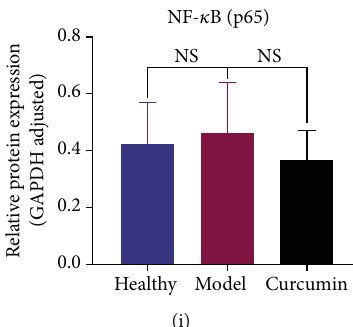
Figure 8: Curcumin treatment reduces ubiquitination and NF- κ B activity in muscle tissue of tumor-bearing mice. (a – c) Statistical analysis of atrogin-1, MuRF-1, and NF- κ B mRNA expression of mouse gastrocnemius in three groups. (d) Western blot bands of atrogin-1 and MuRF-1 protein in gastrocnemius of the three groups. (e) Western blot bands of P65 and P-P65 protein in gastrocnemius of the three groups. (f – i) Statistical analysis of atrogin-1, MuRF-1, P-65, and PP-65 protein expressions in gastrocnemius of three groups of mice. NS: not signi fi cant; ∗ p < 0 : 05 , ∗∗ p < 0 : 01 , and ∗∗∗ p < 0 : 001 by t -test, compared to the model group. Data was shown as mean ± standard errorsof themean .